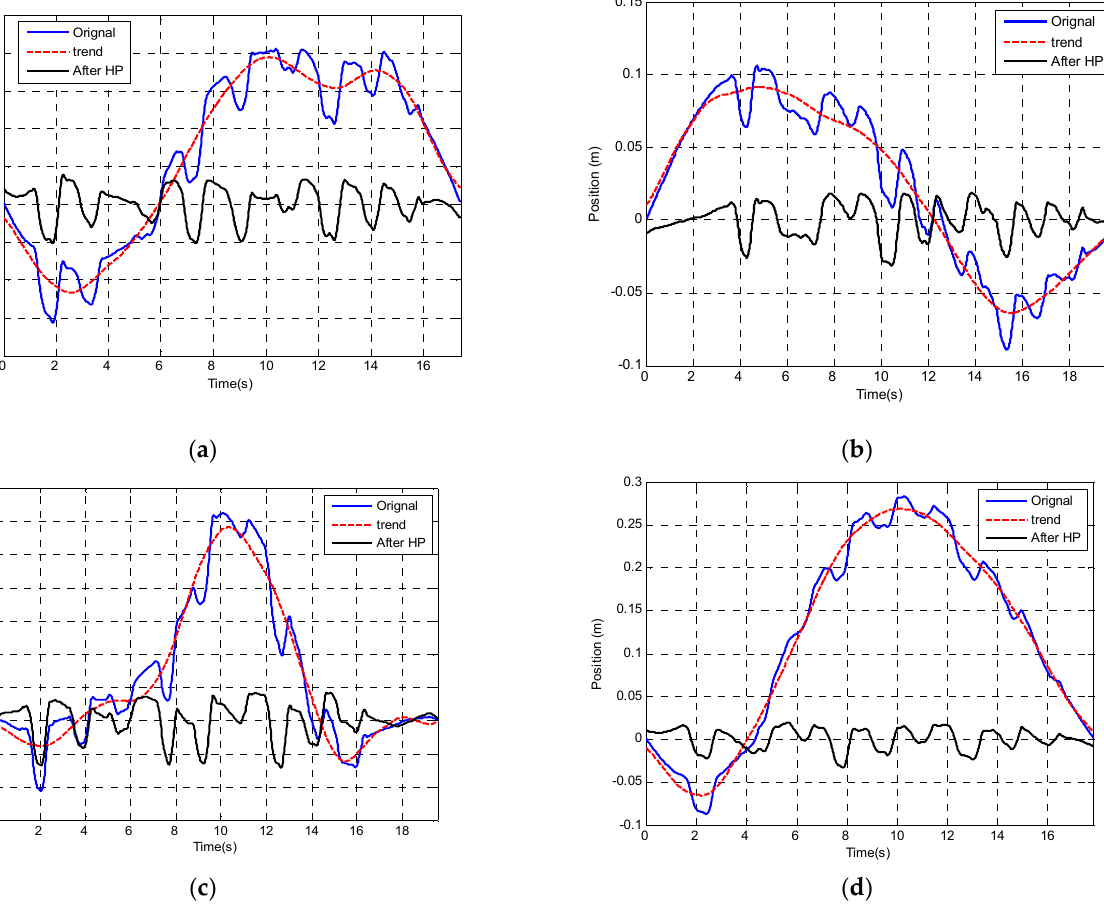
Figure 15. Drift correction result after applying the 0.03 Hz HP filter. ( a ) Experiment Test 1. ( b ) Experiment Test 2. ( c ) Experiment Test 3. ( d ) Experiment Test 4.